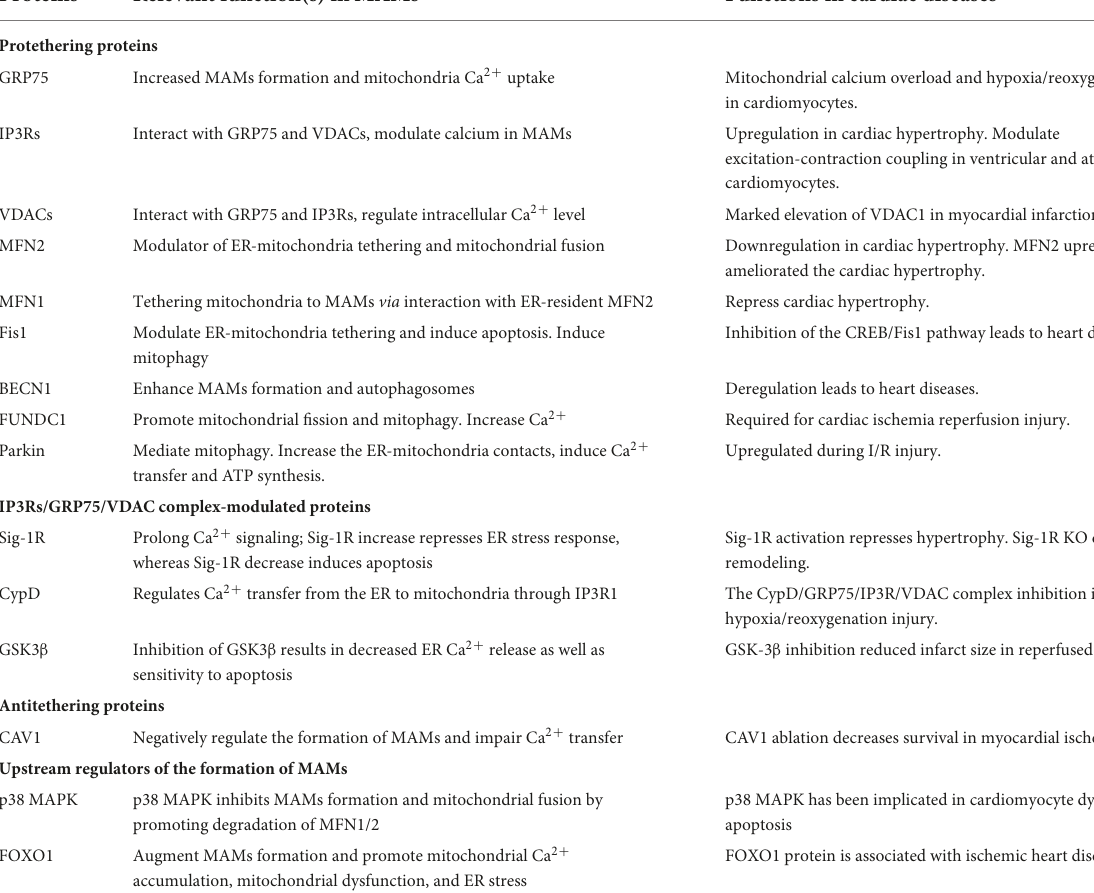
TABLE 1 Components of MAMs involved in cardiac